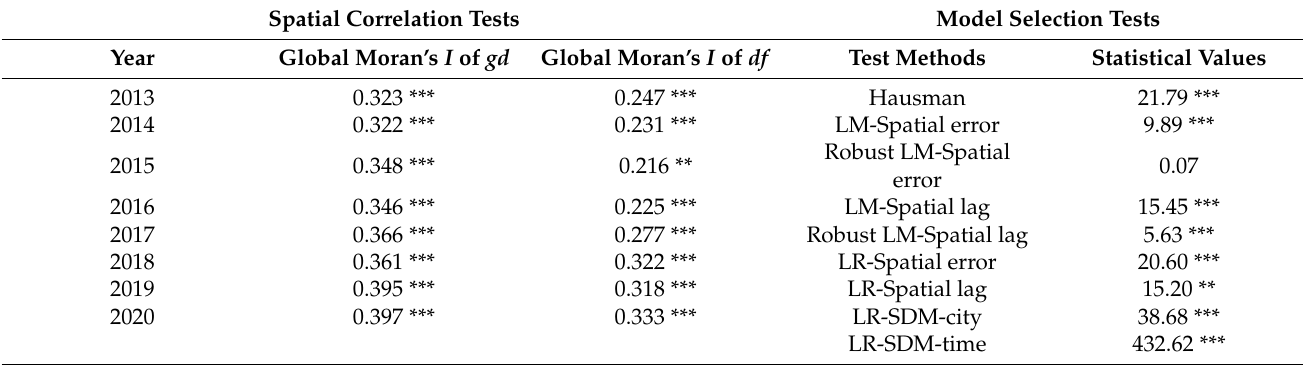
Table 3. Spatial correlation and econometric model selection tests.